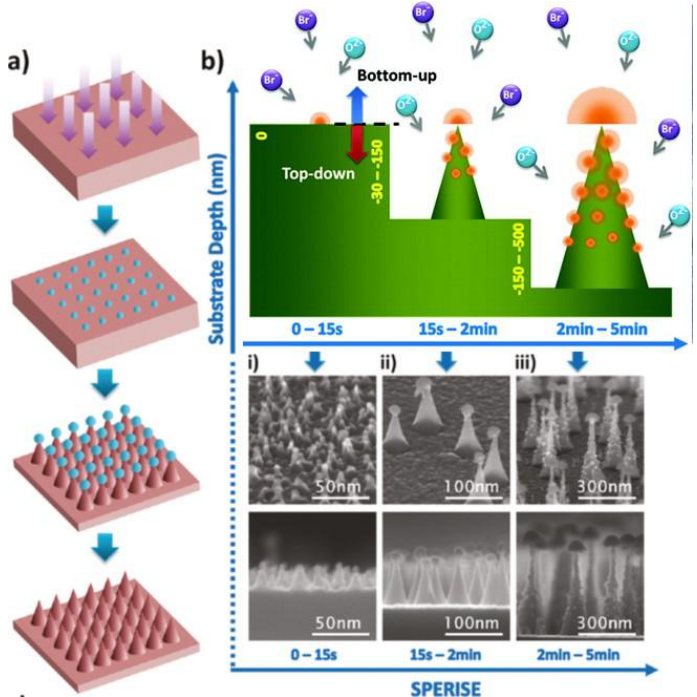
Figure 9. Simultaneous plasma enhanced reactive ion synthesis and etching (SPERISE) process and Si nanocone formation mechanism. ( a ) Process flow of the nanomanufacturing process: Pseudo randomly distributed silicon oxybromide nanodots are synthesized on the planar silicon substrate surface in the first few seconds of the SPERISE process. The oxide nanodots grow to hemispheres by a phase-transition nucleation process and act as a protective nanomask for the simultaneous reactive ion etching of the silicon underneath. Depending on the growth rate of the oxide hemispheres and the crystalline structures of the silicon substrates, nanocones with different aspect ratios are formed. The silicon oxybromide nanohemispheres on top of the nanocones are removed by wet etching; ( b ) Detailed schematic drawing of the three typical stages in the SPERISE process: Bromine and oxygen reactive ions interact with silicon to form synthesized oxide hemisphere and dots (orange) and etched silicon cone structure (green). Both the illustrations and corresponding SEM images at (i) 0–15 s; (ii) 15 s–2 min; and (iii) 2–5 min in the SPERISE process manifest this unique nanomanufacturing method (Reproduced with permission from [129]. Copyright American Chemical Society,